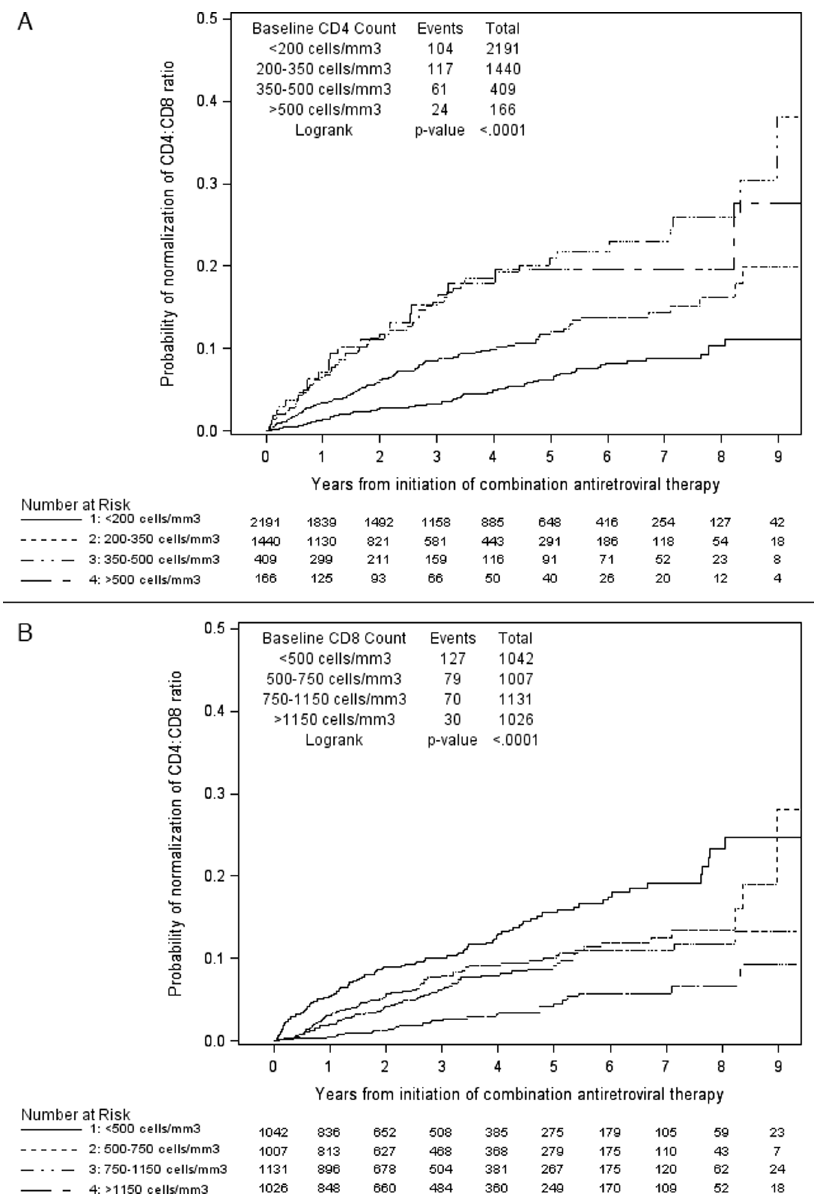
Figure 1. Kaplan-Meier curves of time to CD4:CD8 normalization by: (a) baseline CD4 + T-cells; (b) baseline CD8 + T-cells.